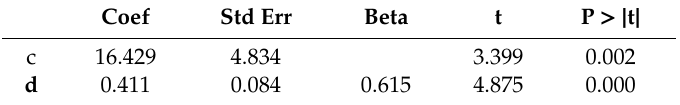
Figure 5. Public transport mode share over individualism-collectivism dimension.